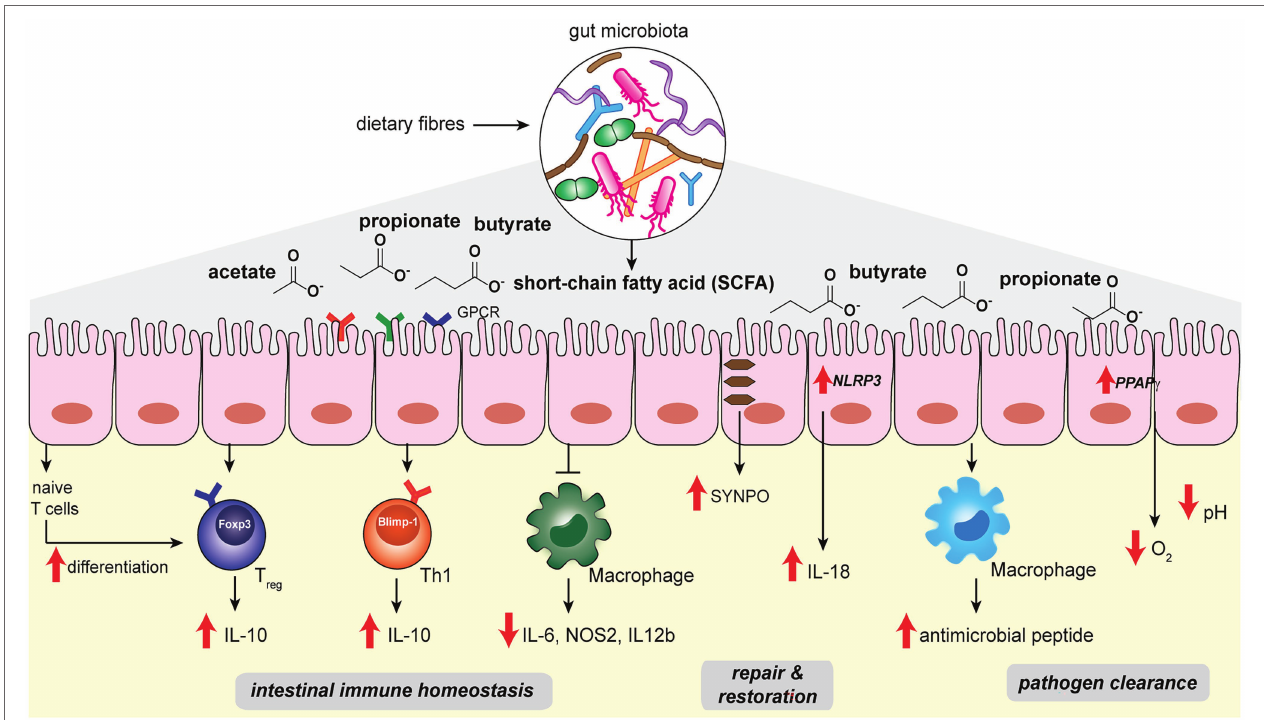
FIGURE 1 | Gut microbiota-derived short-chain fatty acids such as acetate, propionate, butyrate regulate host intestinal immune homeostasis, epithelial repair and restoration, and facilitate pathogen clearance in the host gut